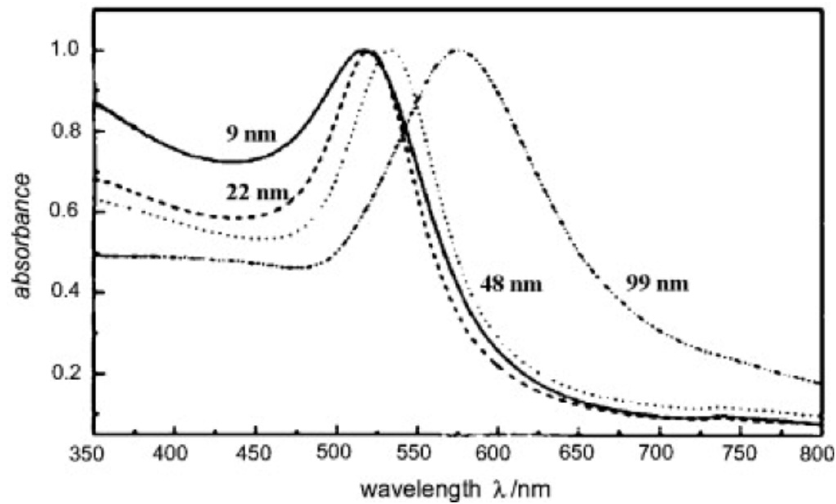
Figure 6. The UV–visible spectra of AuNPs with different sizes [107]. Copyright Elsevier